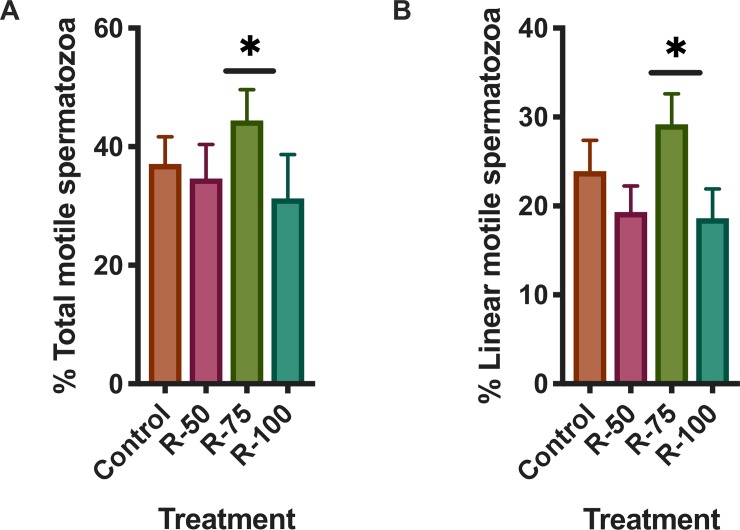
Effect of rosiglitazone added to the thawing media on stallion sperm motility.Samples were processed as described in the Materials and Methods and supplemented in the thawing media with rosiglitazone (0, 50, 75 and 100 μM) and then incubated at 37°C for two hours; then the motility was evaluated using a computer assisted system (CASA). Rosiglitazone at 75 μM increased the percentage of total (A) linearly motile (B) spermatozoa (P<0.01) (results are derived from three independent frozen ejaculates from 6 different stallions n = 18).